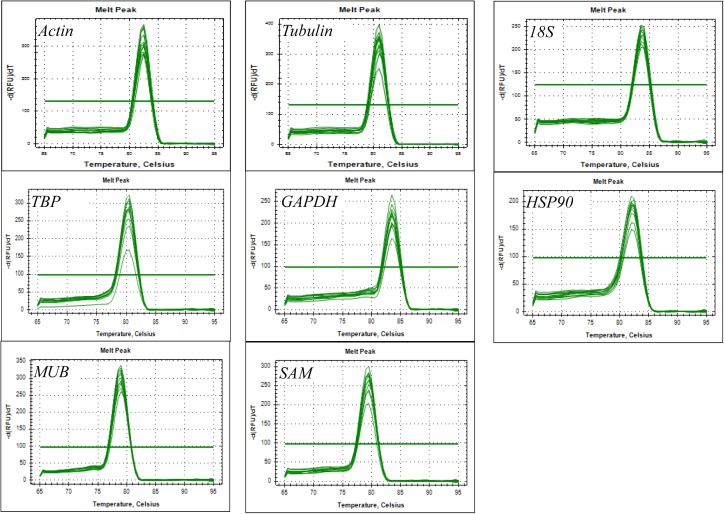
Amplification specificity of primers for qRT-PCR amplification. Melting curves of eight candidate reference genes.